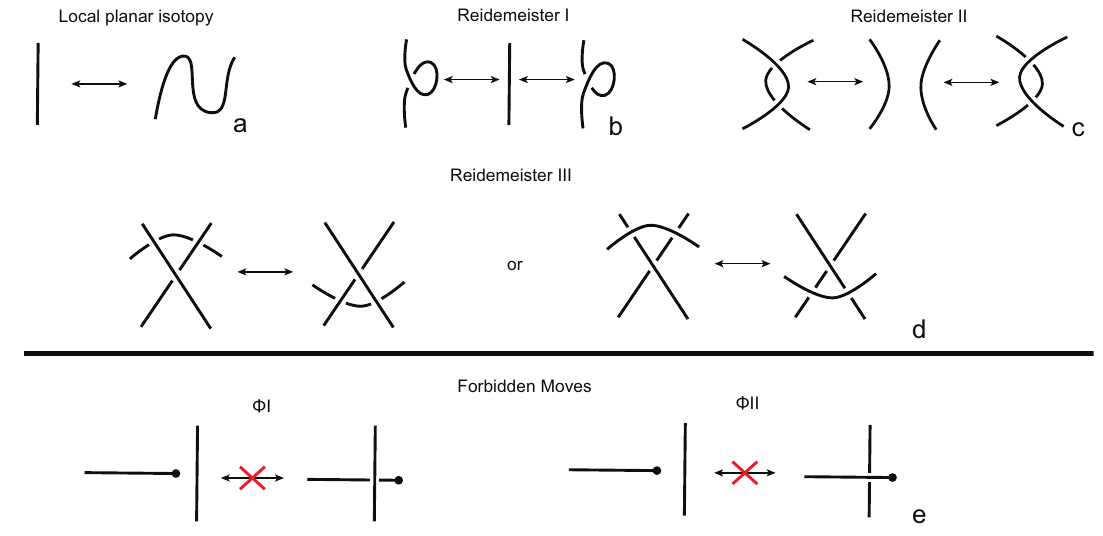
Figure 2. The Reidemeister moves ( a – d ) and the forbidden moves ( e ) on a knotoid diagram.